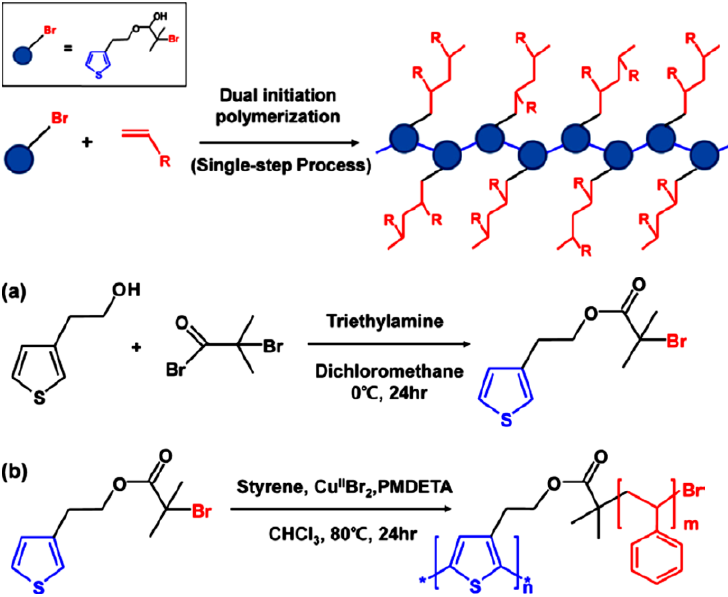
Figure 6. Schematic illustration and synthetic route of the synthesis of π -conjugated polymers bearing branched chains via the dual initiation polymerization process. Reproduced with permission [65].